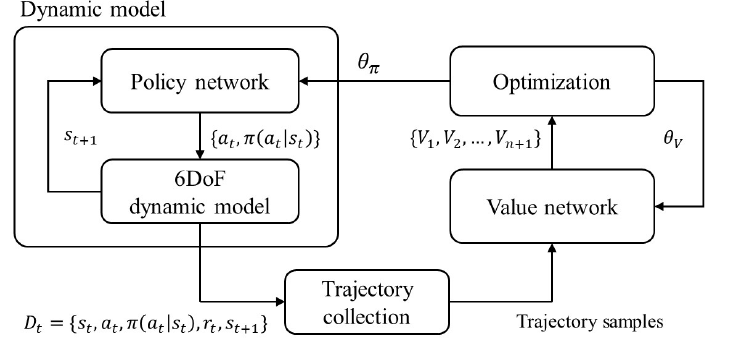
Figure 6. Block diagram of the training process. The D t are the data generated by the dynamic model which include the state of the dynamic model s t , action a t determined by the policy function, the policy probability π ( a t | s t ) , and the reward r t . The generated data are collected as the trajectory sample and used in the optimization